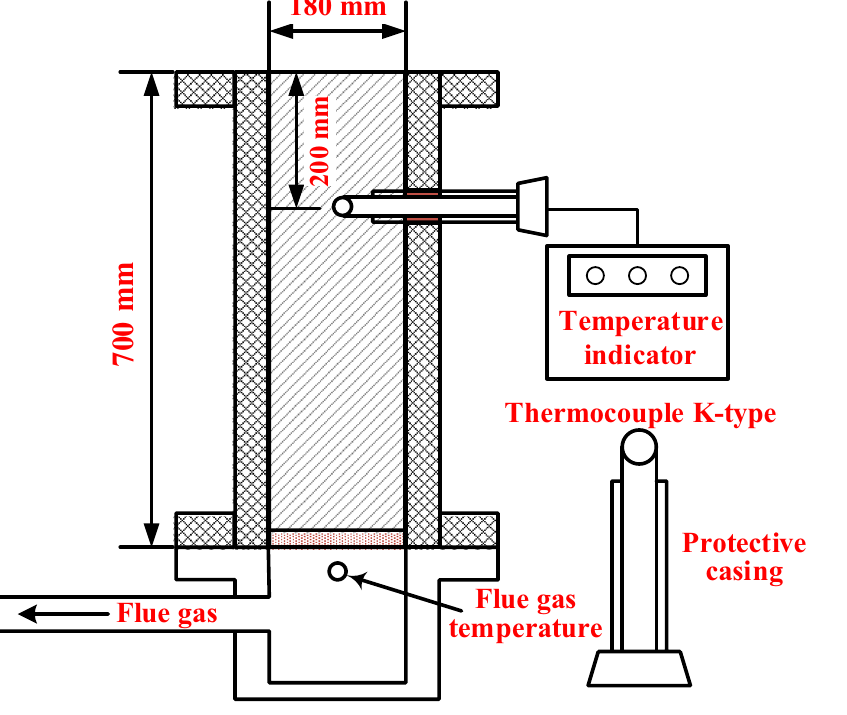
Figure 1. Schematic of the sinter pot used in the sintering